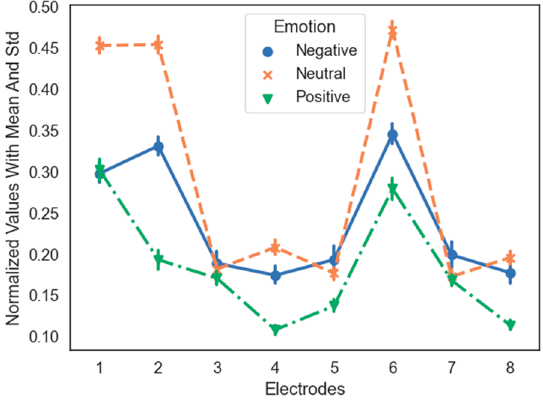
Figure 8. Normalized values with the mean and standard deviation of three emotional states across each electrode using SAE on Subject 2. Table 1. EEG electrode selection for SAE over Subject 2.